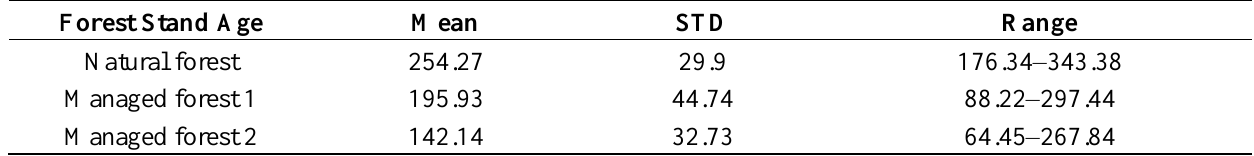
Table 3. Summary of field forest AGB